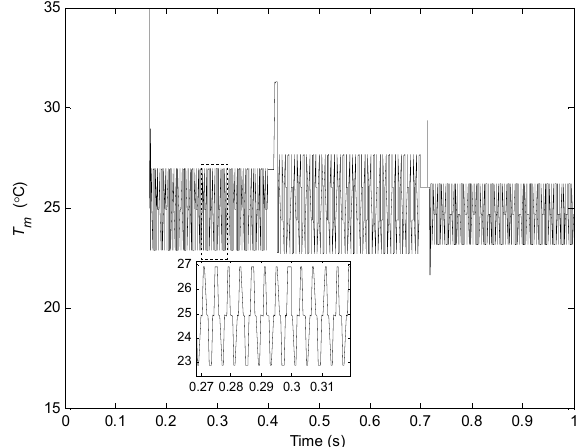
Figure 20. Curve in second simulation.